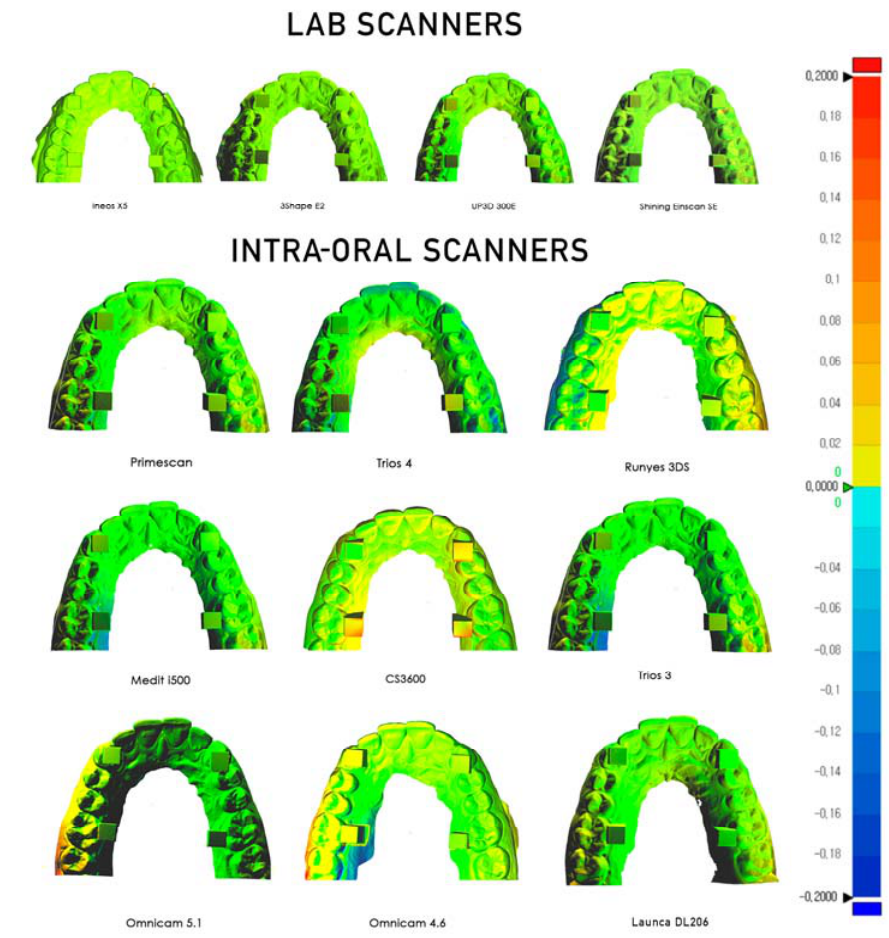
Figure 5. Colorimetric map of the deviation.